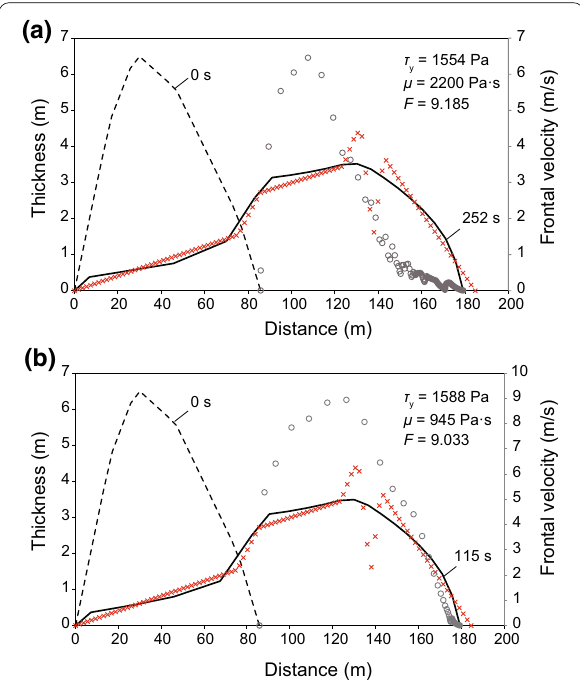
Fig. 6 Results of forward modeling of the debris flow with optimized viscosity and yield stress parameters. The thickness of the deposit is plotted against distance from the top of the source area. a Results of the high-viscosity debris flow with τ y b Results of the low-viscosity debris flow with τ y µ 945 Pa s. Black dashed line: initial deposit profile; black line: final = modeled deposit profile; red crosses: observed deposit profile; grey circles: frontal velocity of the debris flow